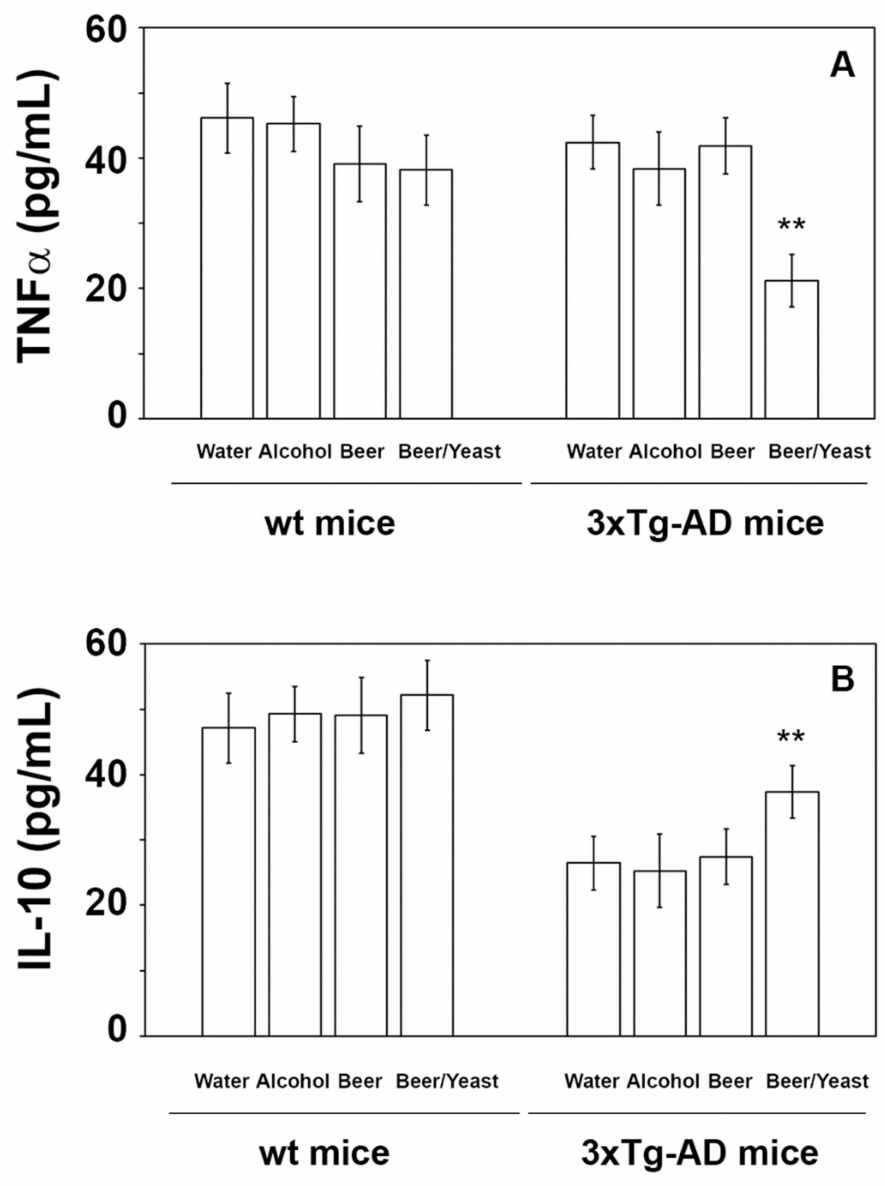
Figure 4. Levels of TNF- α ( A ) and IL-10 ( B ) measured by ELISA on plasma samples of the wt and 3xTg-AD mice treated with water, alcohol, beer and beer/yeast. No changes were detected in the wt animals, whereas TNF- α decreased and IL-10 increased in 3xTg-AD mice upon beer/yeast administration. Concentrations are expressed as pg/mL. HIP: hippocampus; PFC: prefrontal cortex. (** p < 0.01 B/Y vs. W, A and